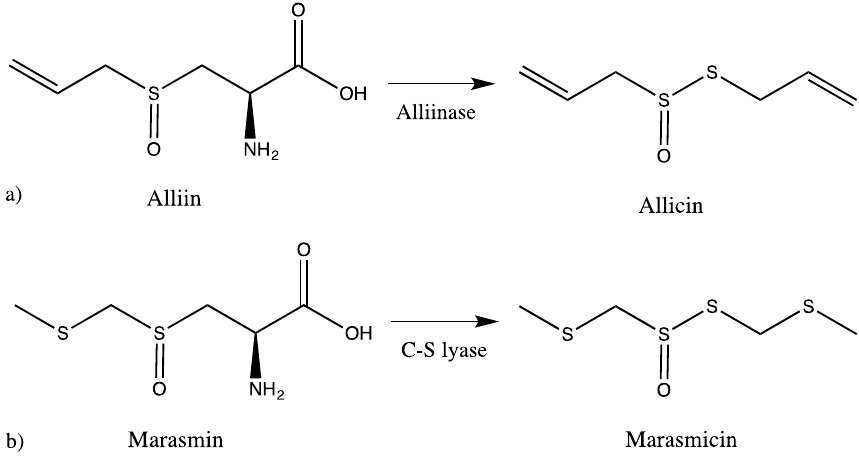
Figure 1. Pathways leading to the production of sulfur-containing compounds in ( a ) Allium and ( b ) Tulbaghia